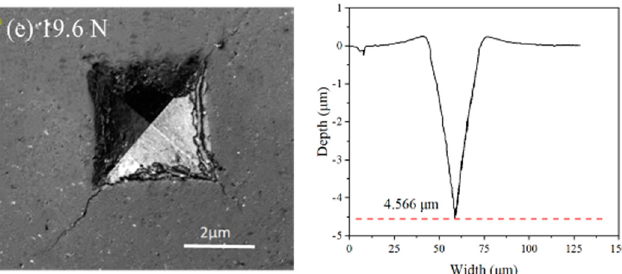
Figure 9. Indentation micrograph and depth curve of Si 3 N 4 material under different loadings: ( a ) 1.96 N; ( b ) 2.94 N; (c ) 4.9 N; ( d ) 9.8 N; ( e ) 19.6 N.